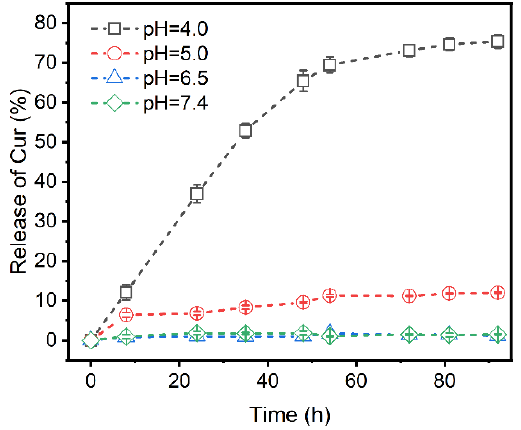
Figure 8. Release profiles of Cur-loaded CS nanocomplex at different pH.